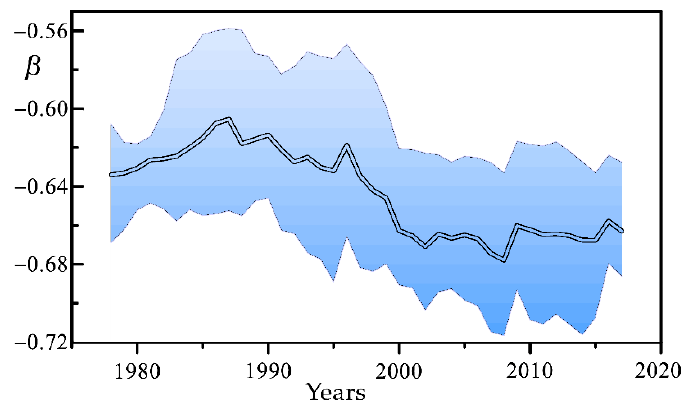
Figure 11. Temporal evolution of the mean value of the scaling parameter 𝛽 in Andalusia. The shaded area represents dispersion ( ±𝜎 ).